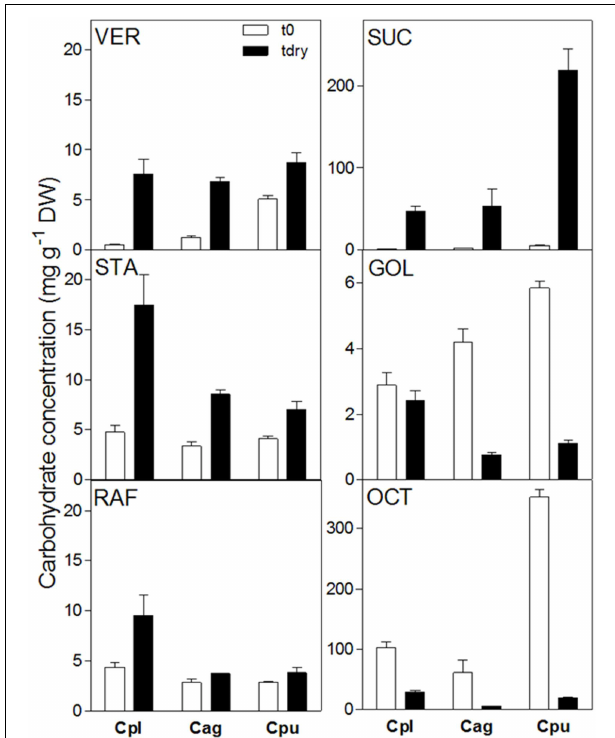
FIGURE 5 | Comparison of water soluble carbohydrate concentrations in the leaves of C. plantagineum , C. agnewi , and C. pumilum plants in the fully hydrated state (t0) and the 5% RWC dried state (tdry). WSCs were analyzed by HPLC-PAD using MA1 and BC100 columns. Error bars indicate the standard error between the mean of six replicates. Suc, sucrose; Oct, 2-octulose; Gol, galactinol; Raf, raffinose; Sta, stachyose; Ver, verbascose, Cpl, C. plantagineum ; Cag, C. agnewi ; Cpu, C. pumilum